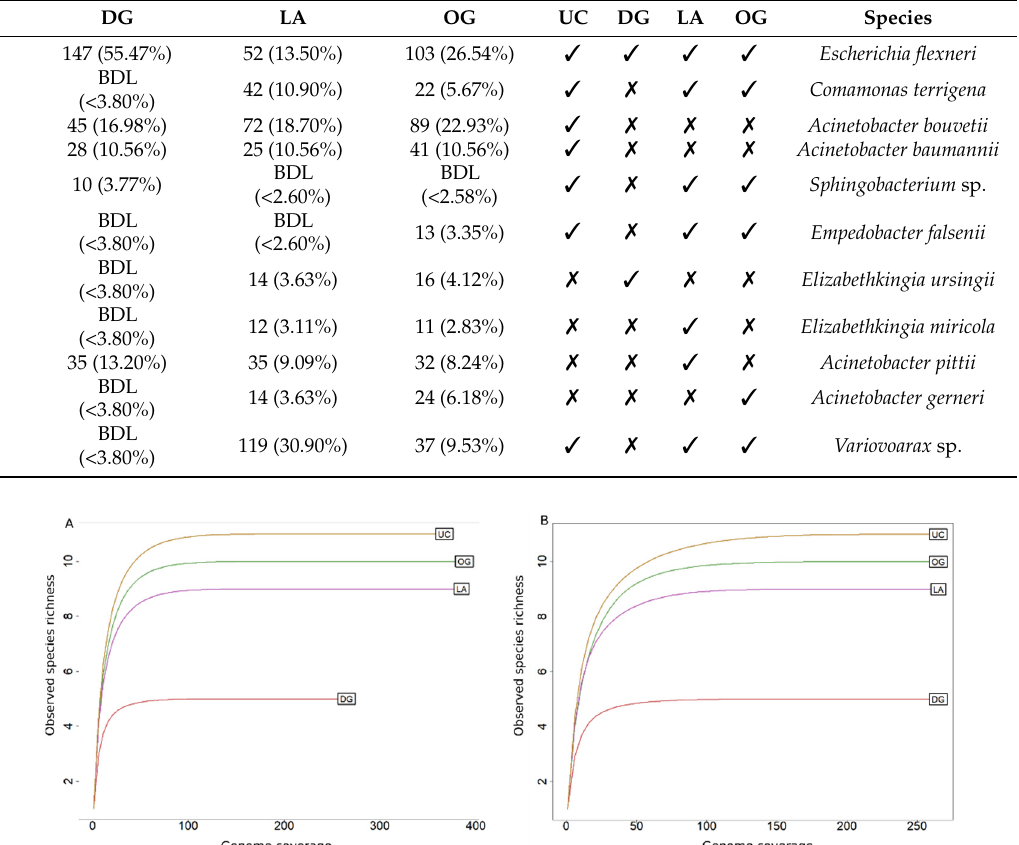
Figure 4. Rarefaction curves showing the observed time coverages of species in unsorted and sorted sub-communities. Reads were transformed to coverage before plotting the curves. (UC: Unsorted community; OG: Outer sub-community; LA: Low abundant sub-community; DG: Dominant sub- community; ( A ): before rarefaction; ( B ): after rarefying the data to 265 times genome sorted and sorted sub-communities to access the fraction of reads of gOTUs in each met- agenome. After calculating the coverage, 11 taxa remained since one taxon ( C. B- 9) was found below the detection limit in all groups (Table 1) and removed from further analyses. The average detection limit of the gOTUs with coverage above ten times was 2.92% (±0.57). The rarefaction curves of genome coverage of the microbial communities observed in the unsorted and sorted sub-communities are illustrated in Figure 4, where all commu- nities were able to achieve their plateau for the given cut-off coverage.